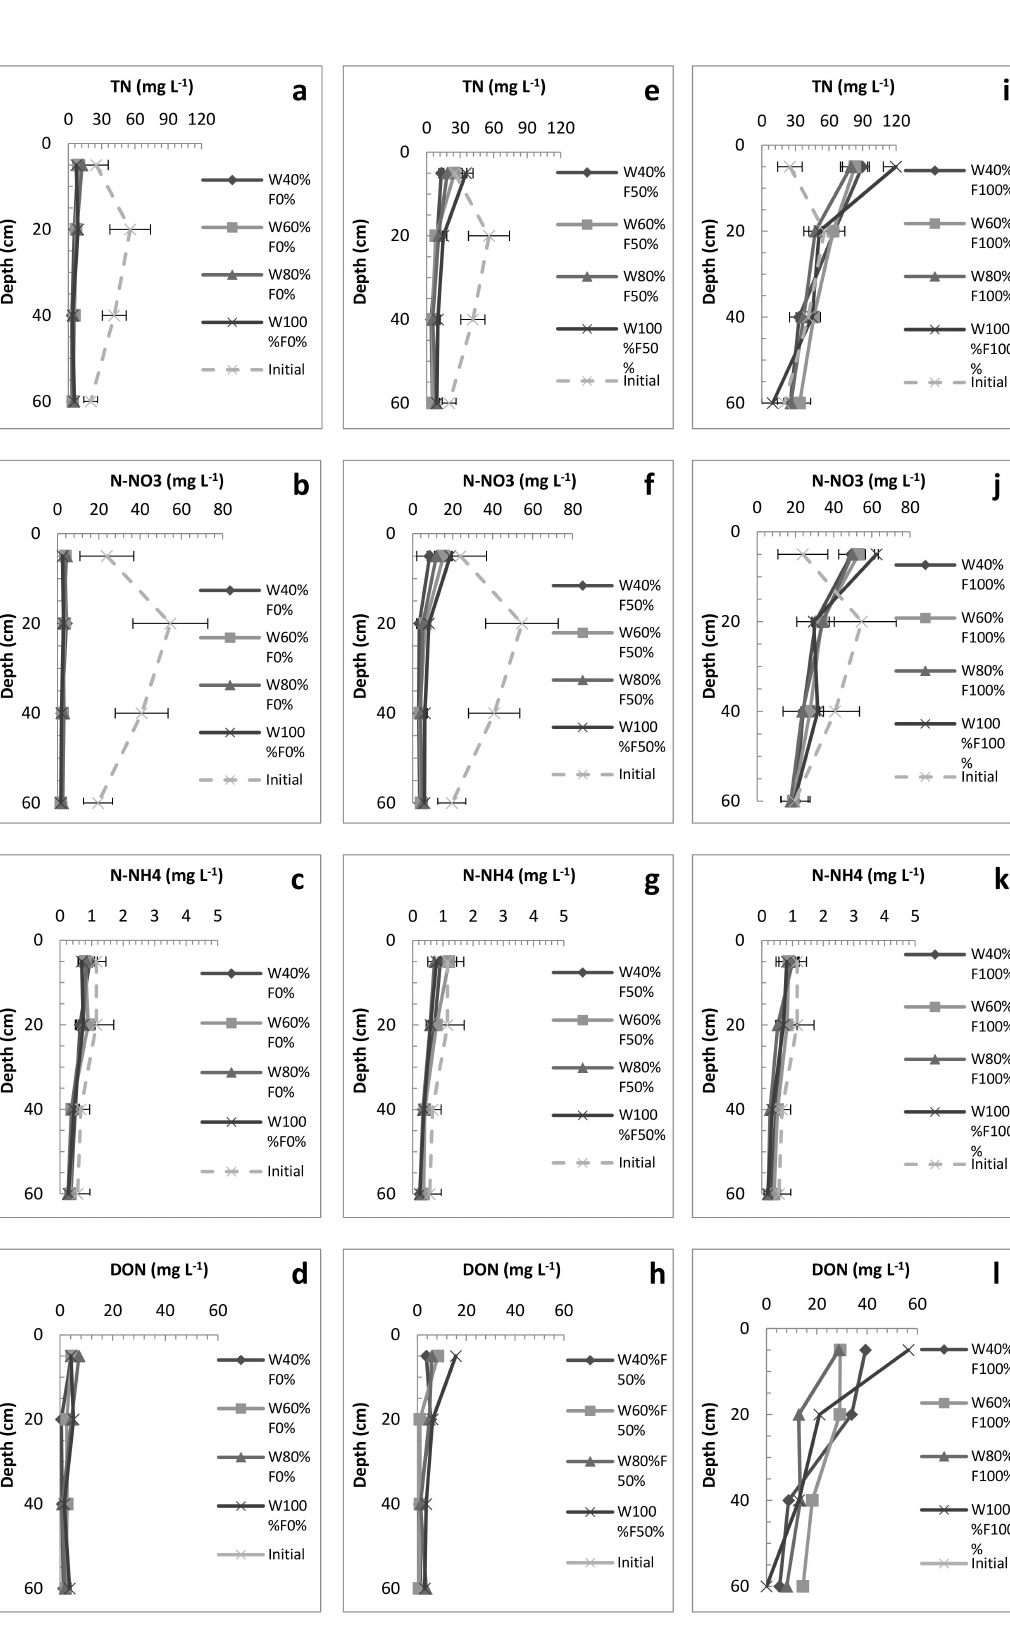
Figure 8. Mean values of soil sample analyses (1:1 soil:water) of TN, NO 3 − , NH 4 + and DON at four different depths (5, 20, 40, and 60 cm) according to the irrigation regime. The dashed line (‘initial’) represents the sampling at the beginning of the season. ( a – d ) F0%; ( e – h ) F50%; ( i – l )